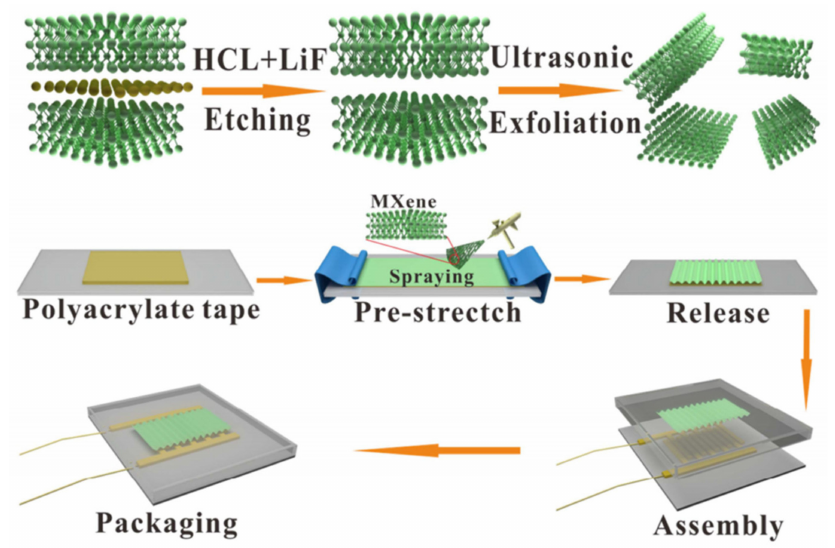
Figure 33. Schematic diagram of the preparation procedure used to fabricate the piezoresistive sensor based on MXene composite with wrinkled structure. Reproduced with permission from reference [126]. Copyright 2018, Elsevier